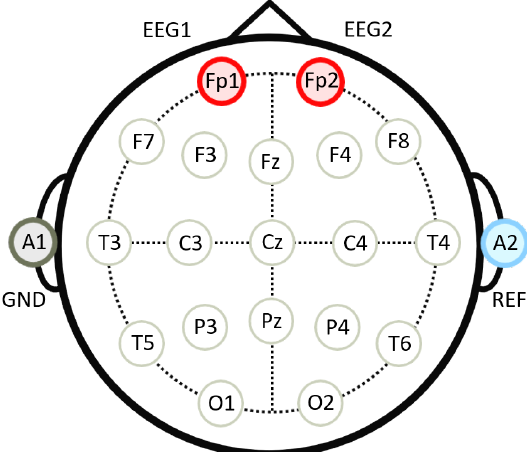
Figure 3. Positions of the attached